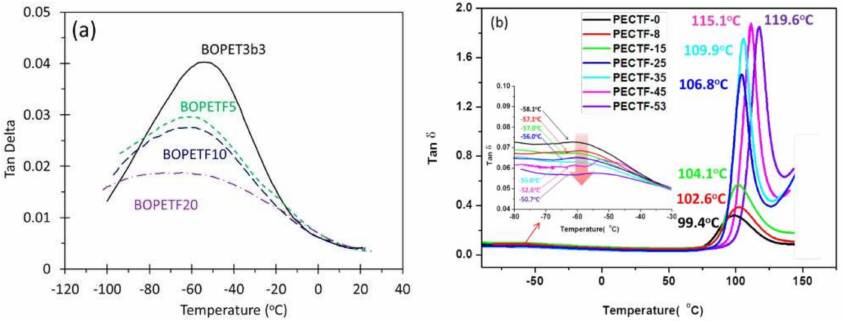
Figure 17. Influence of the introduction of FDCA on the polymer’s structure on ( a ) T g [41] and ( b ) T g and β relaxation